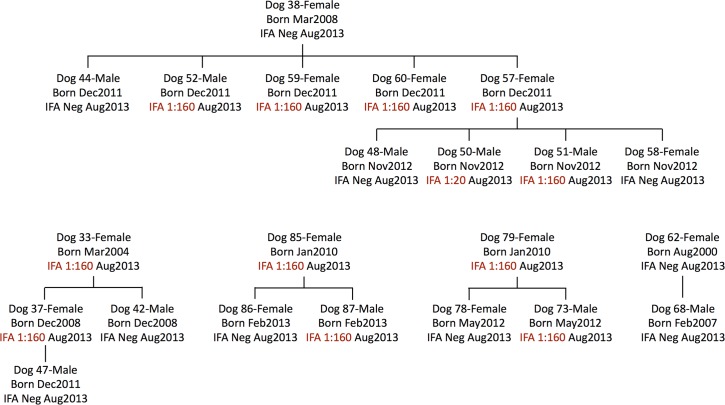
Lineages of five groups of related dogs.Each dog is represented by its number, sex, date of birth, and IFA status at time of August 2013 testing. Dams Dog 62, Dog 79, and Dog 85 were from kennel A, dams Dog 33, Dog 37, Dog 38, and Dog 57 were from kennel C.